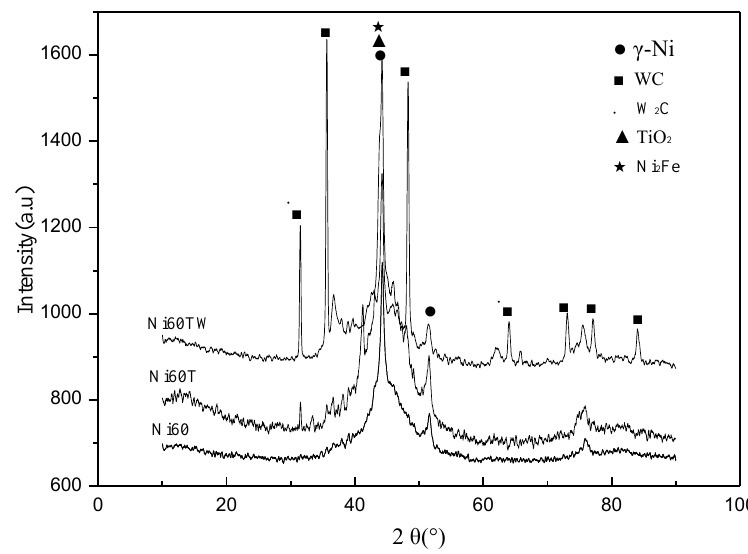
Figure 4. XRD spectrum of composite ceramic coatings.